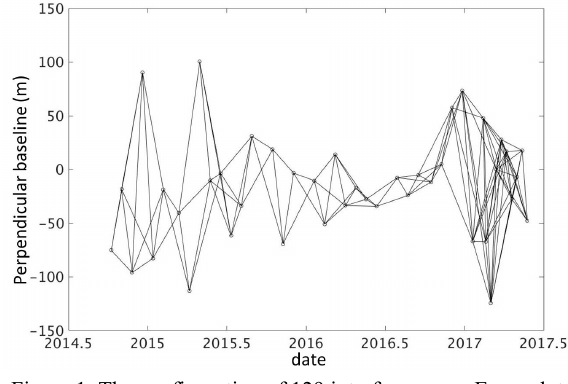
Figure 1. The configuration of 129 interferograms. Every dot represents a SAR image, while each line corresponds to one